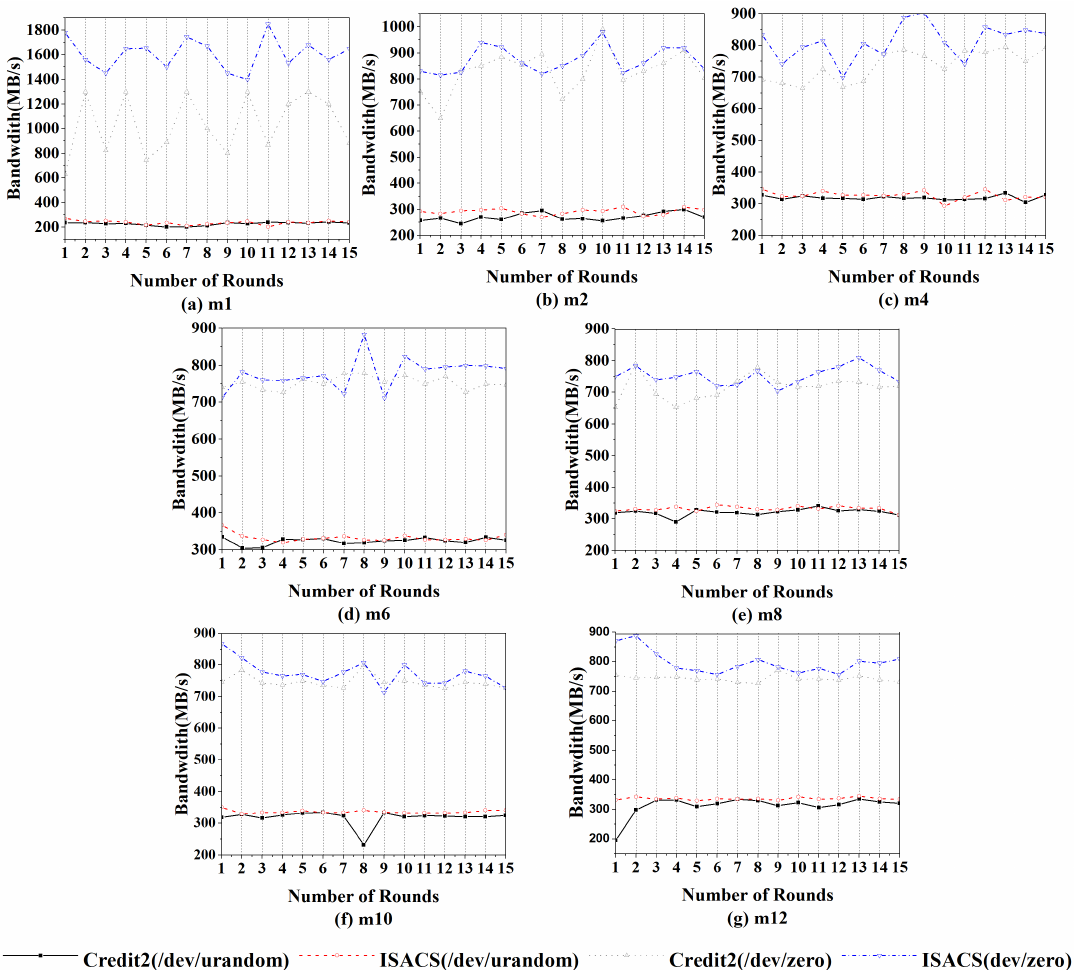
Figure 12. Disk bandwidth in 15 experiments according to the VM configuration in the mixed